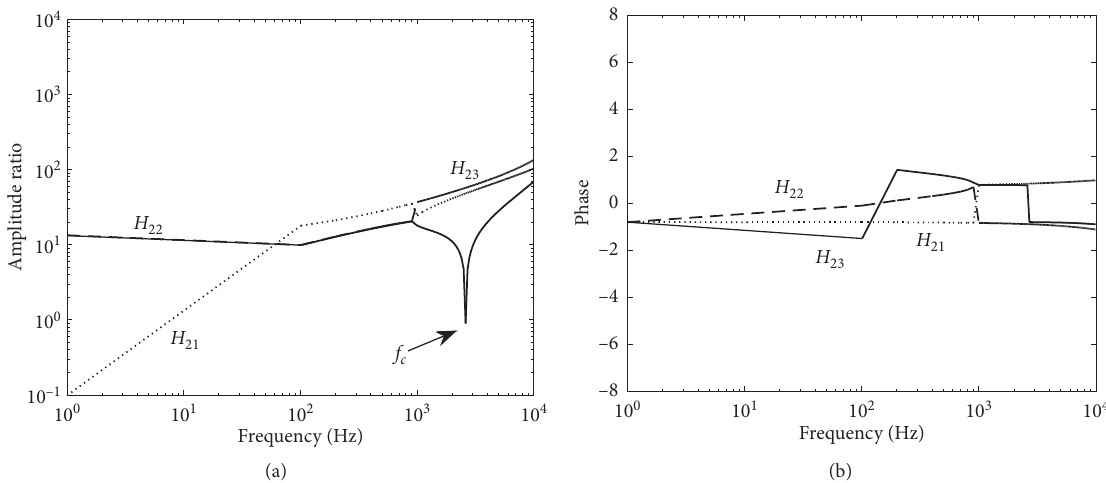
Figure 7: Amplitude ratio and phase of the bending slope to the rotation angle for the curved beam (a) and amplitude ratio (b) phase.